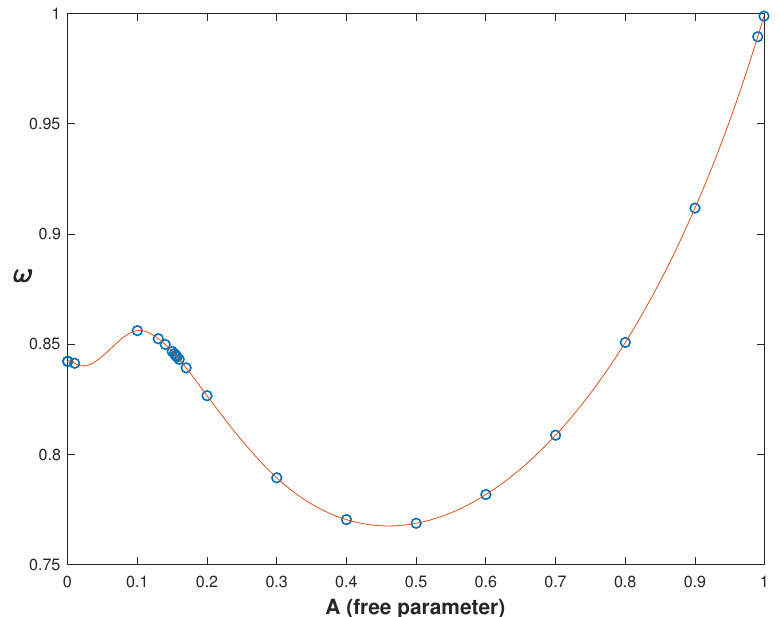
Figure 9. Frequency ω against the free parameter A = f ( 0 ) for the neutral